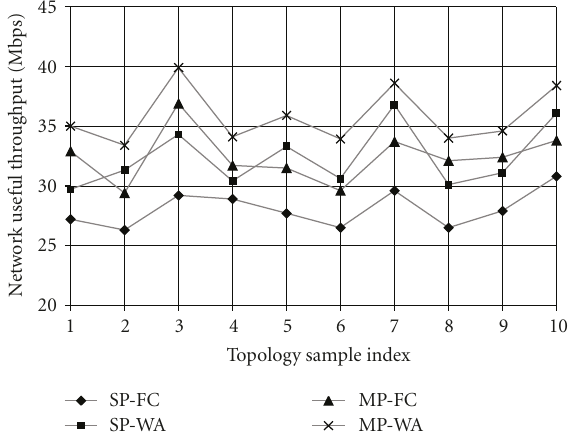
Figure 8: Comparison on the total useful throughput under di ff erent routing schemes across 10 randomly generated topologies.